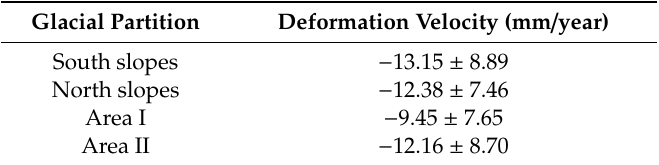
Figure 5. Average annual change rate of glacier deformation obtained from the SBAS InSAR analysis. ( a ) Deformation of north and south slopes. ( b ) Deformation of large glaciers (Area I) and smaller glaciers (Area II). Table 3. Average glacier deformation velocity in different glacial partitions.